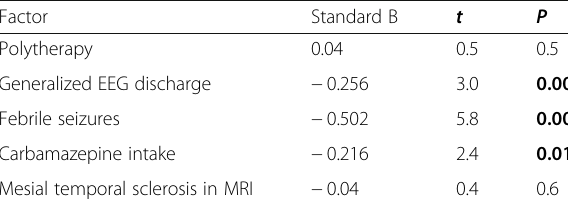
Table 7 Linear regression model for the factors independently related to the zinc level in serum among